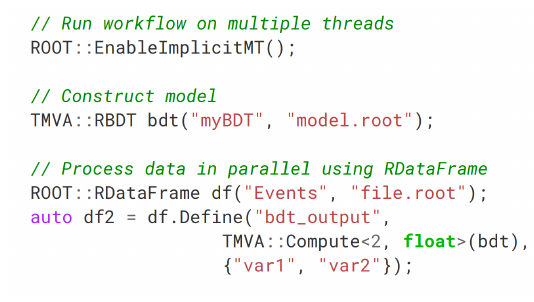
Figure 3. Usage of new TMVA interfaces together with RDataFrame workflows